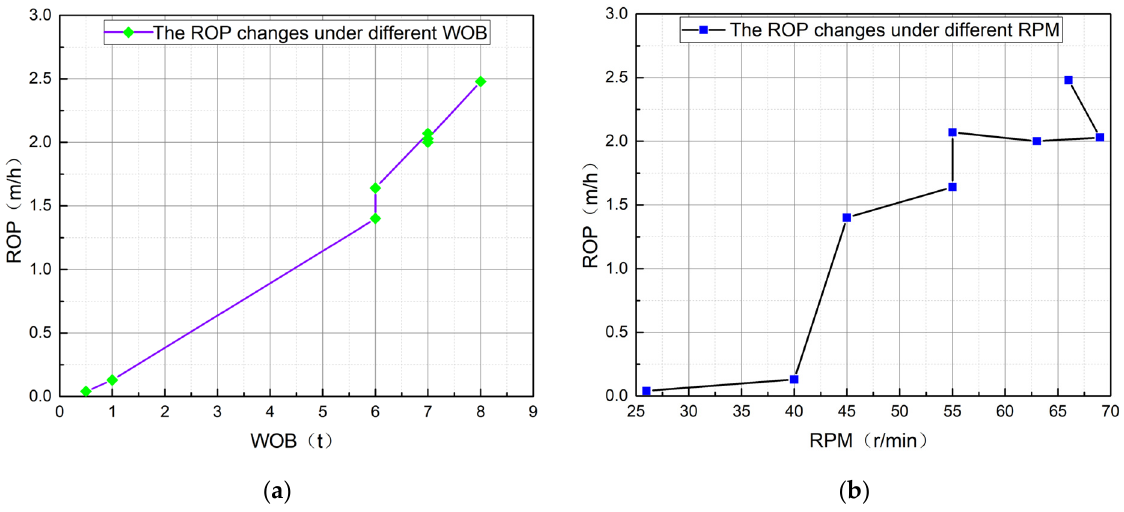
Figure 2. Data of roller core bit: ( a ) The ROP changes under different WOB; ( b ) The ROP changes under different RPM.